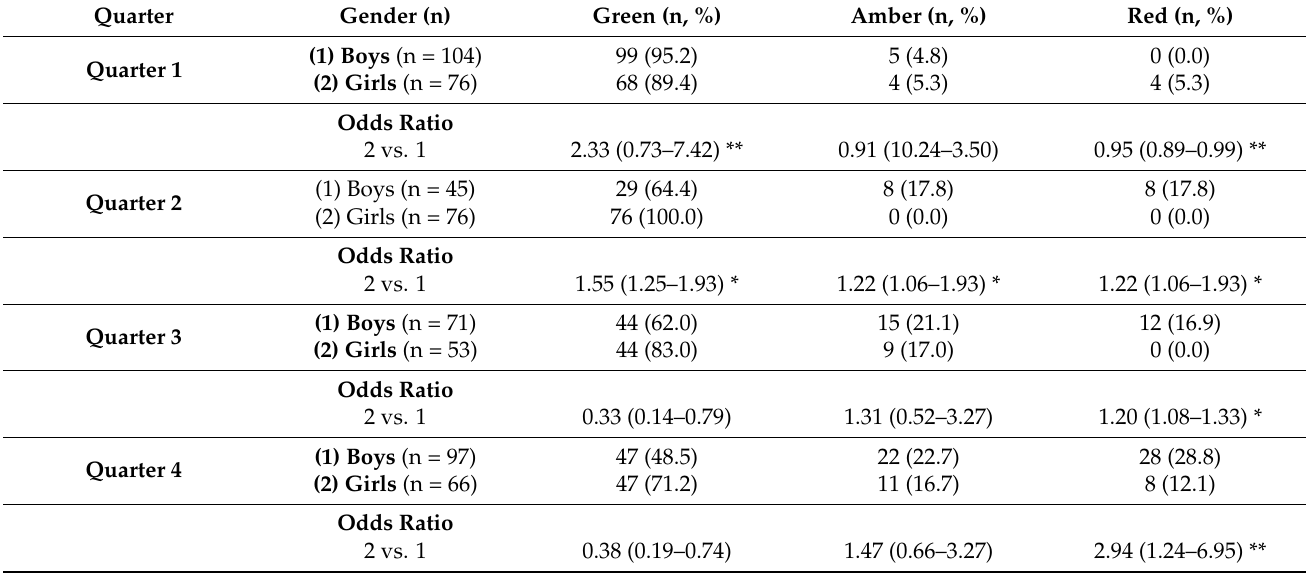
Table 4. Preschool children according to quarter of birth, gender, and traffic light zone of the MABC-2 battery.